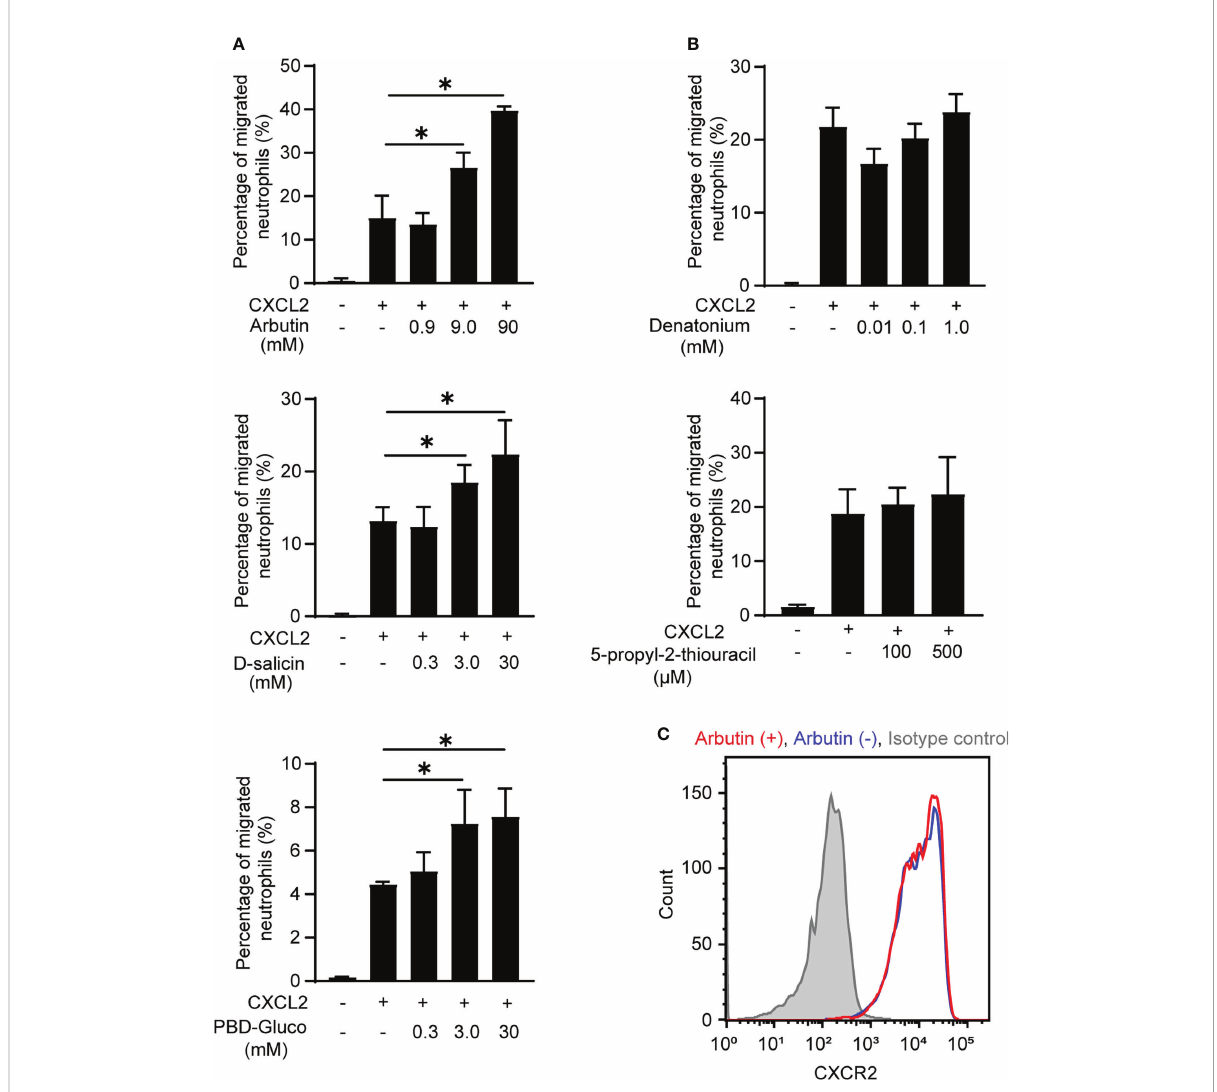
FIGURE 2 Effects of Tas2R126/135/143 agonists on CXCL2-induced neutrophil migration. (A) Transwell migration assays of bone marrow (BM)-derived neutrophils from wild-type C57BL/6 mice after pretreatment with the indicated concentrations of the Tas2R126/143 agonists arbutin and D - salicin or the Tas2R126 agonist PBD-Gluco for 30 min followed by stimulation with 20 ng/ml CXCL2. Data are presented as the mean ± SD of triplicates from one experiment and are representative of three independent experiments. * p < 0.05 by Student ’ s t test. (B) Transwell migration assays of BM-derived neutrophils from wild-type C57BL/6 mice after pretreatment with the Tas2R135 agonists denatonium and 5-propyl-2- thiouracil for 30 min followed by stimulation with 20 ng/ml CXCL2. Data are presented as the mean ± SD of triplicates from one experiment and are representative of three independent experiments. (C) FACS analysis of CXCR2 expression on puri fi ed neutrophils incubated with (red) or without (blue) arbutin. Gray histogram shows the isotype control-stained cells. Data are representative of three independent